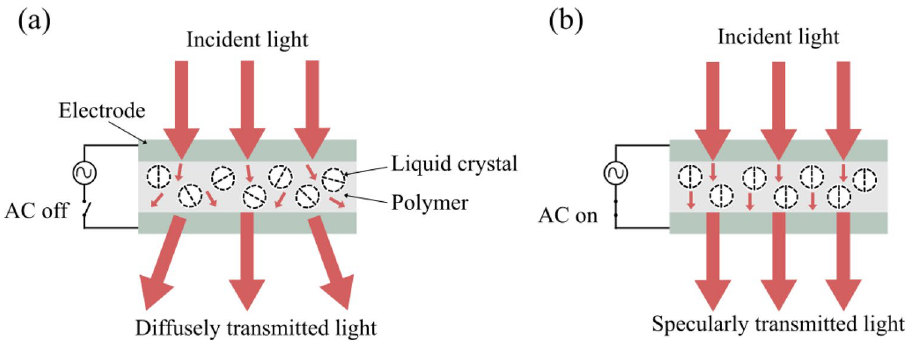
Figure 1. Cross-sectional schematic view of PDLC operation: ( a ) No applied AC electric field. LC droplet orientation is random and transmitted light is scattered; ( b ) AC electric field is applied, the PDLC becomes optically transparent as the LC molecules in the droplets align with the field. Transmitted light is no longer